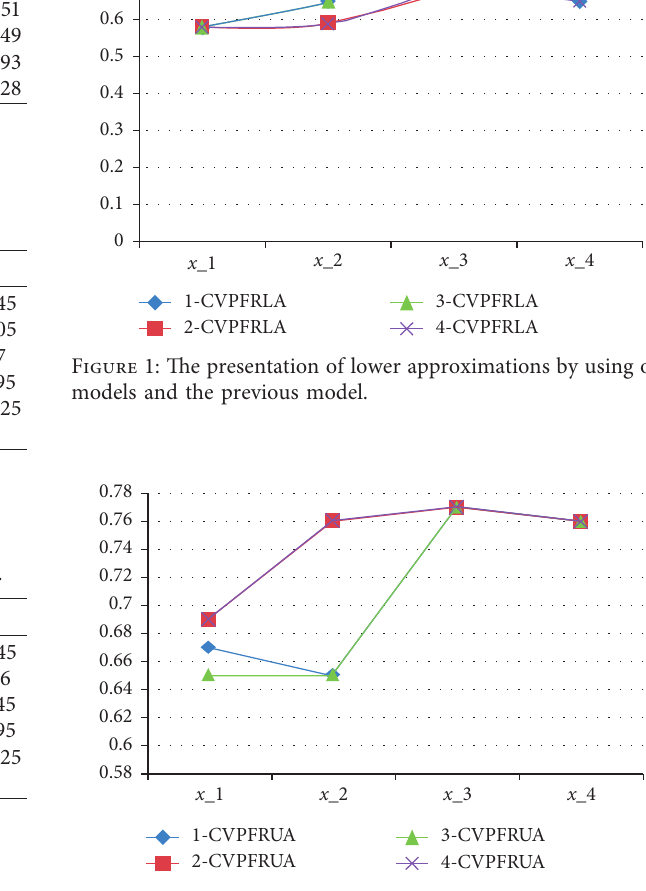
Figure 2: The presentation of upper approximations by using our models and the previous